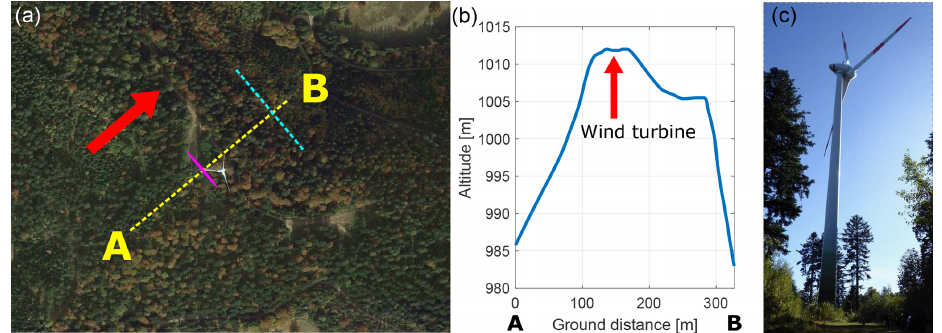
Figure 16. Measurement site of the wind turbine study. (a) The red arrow indicates wind direction. The pink line indicates rotor disc in top view. The dashed cyan line indicates constant altitude flight path of the OPTOkopter. The dashed yellow line indicates the path for the elevation profile shown in the middle (image taken from © Google Earth). (b) Elevation profile of the measurement site. (c) Photograph of the wind turbine in the Black Forest.